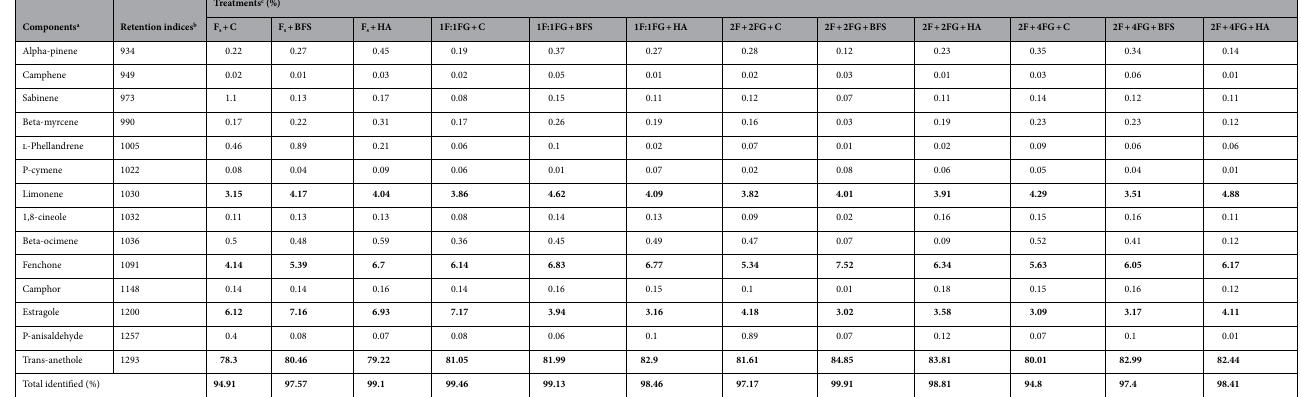
HA and BFS. Compared to the unfertilized control, trans-anethole, fenchone, and limonene contents increased by 2.9%, 21.5%, and 7.9% with BFS and 2.3%, 22.4%, and 11.9% with HA, respectively (Table 3). Fennel oil content and yield. Among the studied treatments, the highest fennel oil content occurred with HA or BFS application in 1F:2FG (16.3% and 16.6%) and 2F:2FG (16.3% and 17.4%), respectively. The lowest fennel oil contents occurred in the unfertilized control, HA, and BFS treatments (12.5%, 12.8%, and 12.9%, respectively)